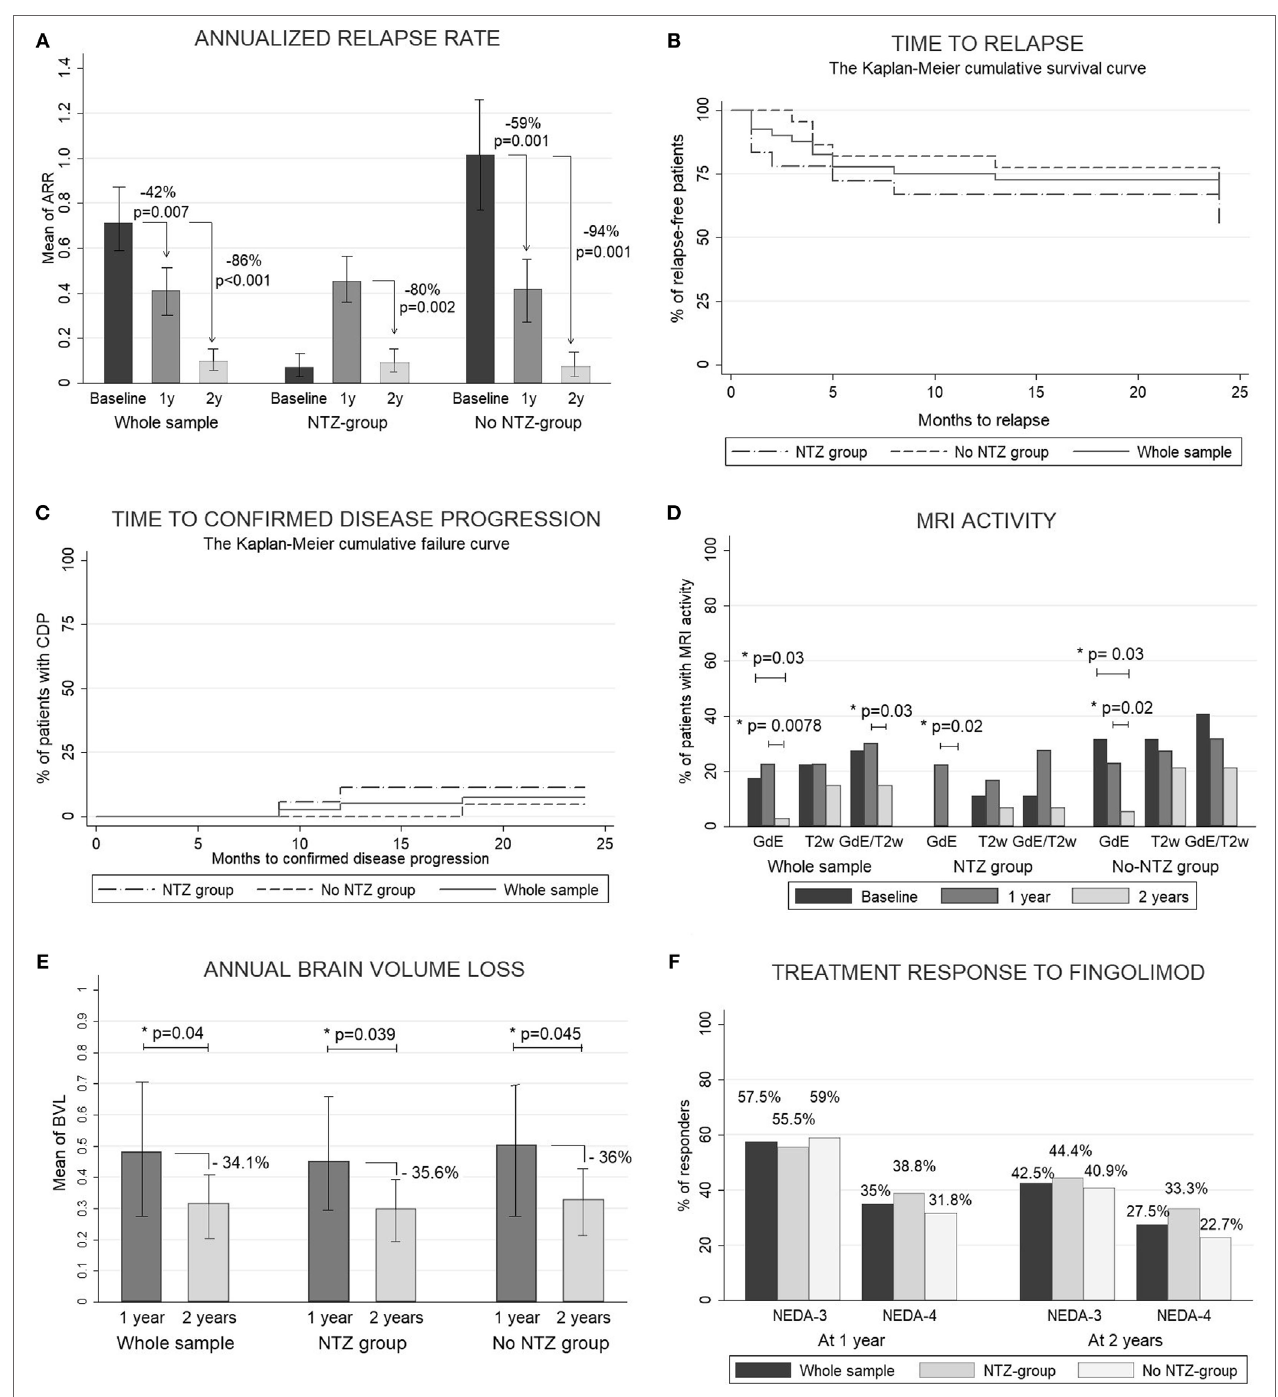
FigUre 1 | Clinical and radiological response. (a) Count data for annualized relapse rate (ARR) were fitted to a zero-inflated Poisson model. Estimated ARRs were calculated at different time periods (baseline, 1 year, and 2 years). To assess the statistical significance between groups, we obtained the p -values by calculating the probability of observing a group rate given the other group rate as the null hypothesis. (B) Kaplan–Meier cumulative survival curve for time to relapse. (c) Kaplan– Meier cumulative failure curve for time to confirmed disease progression. (D) Percentage of patients with magnetic resonance imaging (MRI) activity measured by the development of new gadolinium-enhanced T1 lesions (GdE), new T2-weighted lesions (T2w), or any MRI activity: development of new GdE lesions and/or T2w lesions (GdE/T2w). All measures were acquired at 1 and 2 years. The McNemar test was used to compare percentages between baseline and 1 and 2 years. (e) The Wilcoxon signed-rank test was used to compare the mean of the annual brain volume loss (BVL) between 1 and 2 years (measured by SIENA method). (F) Percentage of patients with a good response to fingolimod according NEDA-3 (no evidence of disease activity: no relapses, no any MRI activity and no clinical disease progression) and NEDA-4 (like NEDA but including BVL < 0.4). p < 0.05 was considered statistically